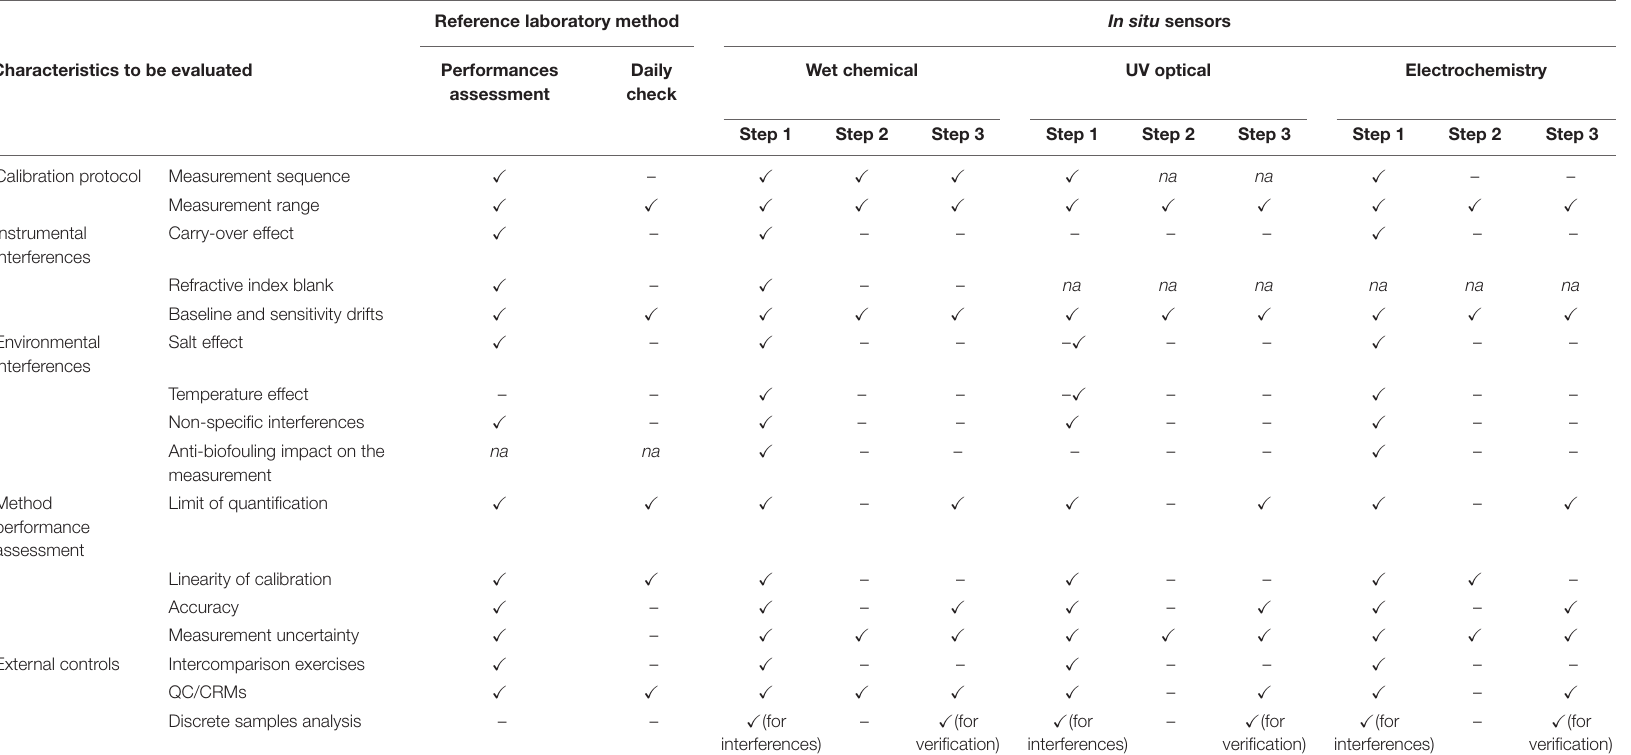
TABLE 5 | A road map for assessing nutrient performances with the laboratory reference method and with each in situ nutrient sensor